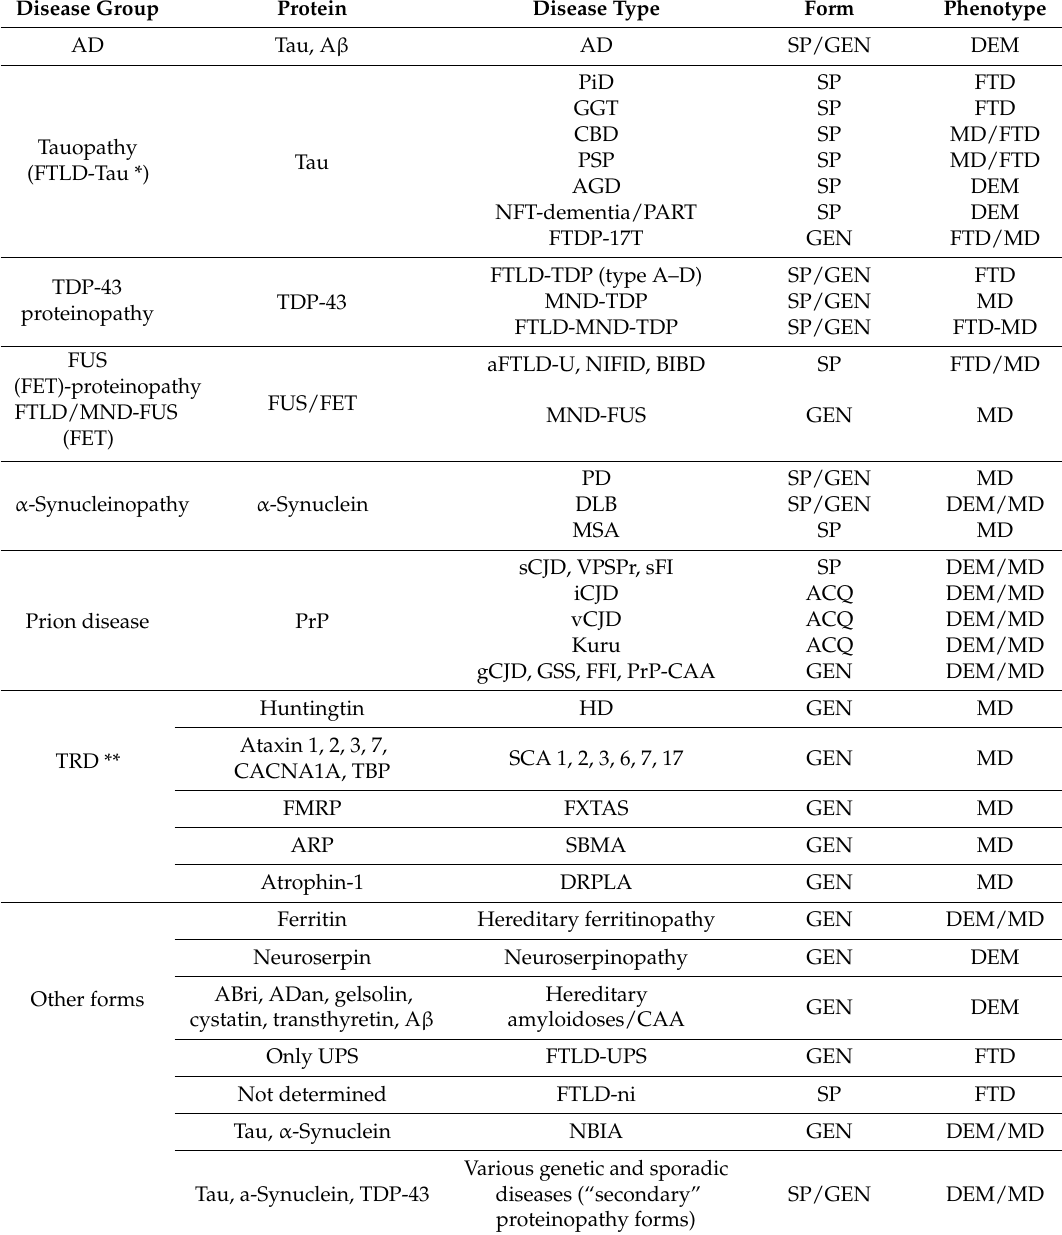
Table 1. Summary of most relevant modifications of neurodegeneration related proteins with